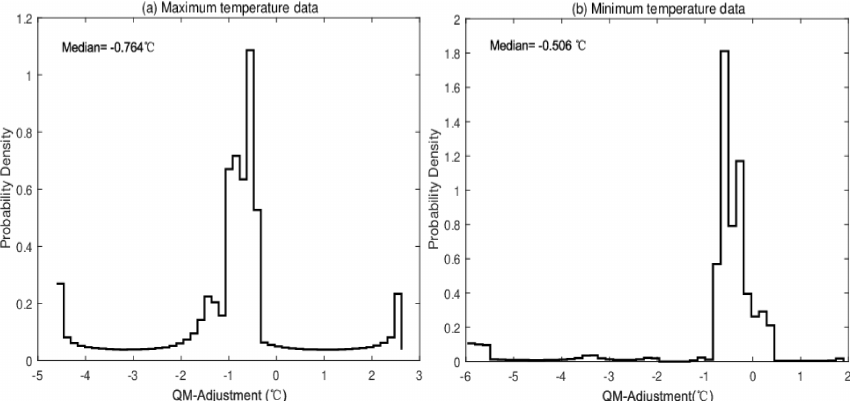
Figure 7. The amplitudes of QM adjustment applied to daily maximum (a) and minimum (b) temperature data at Tianjin Meteorological Observation